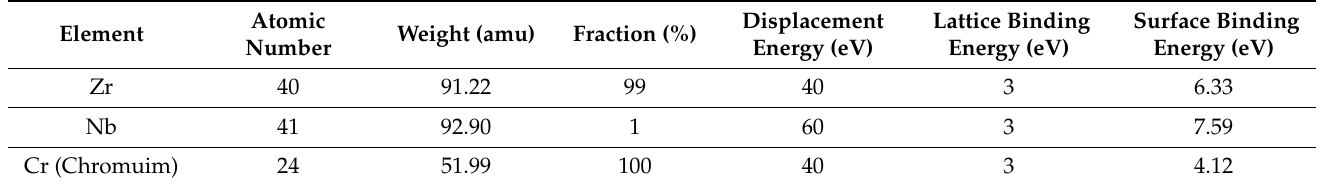
Table 2. Input parameters for TRIM